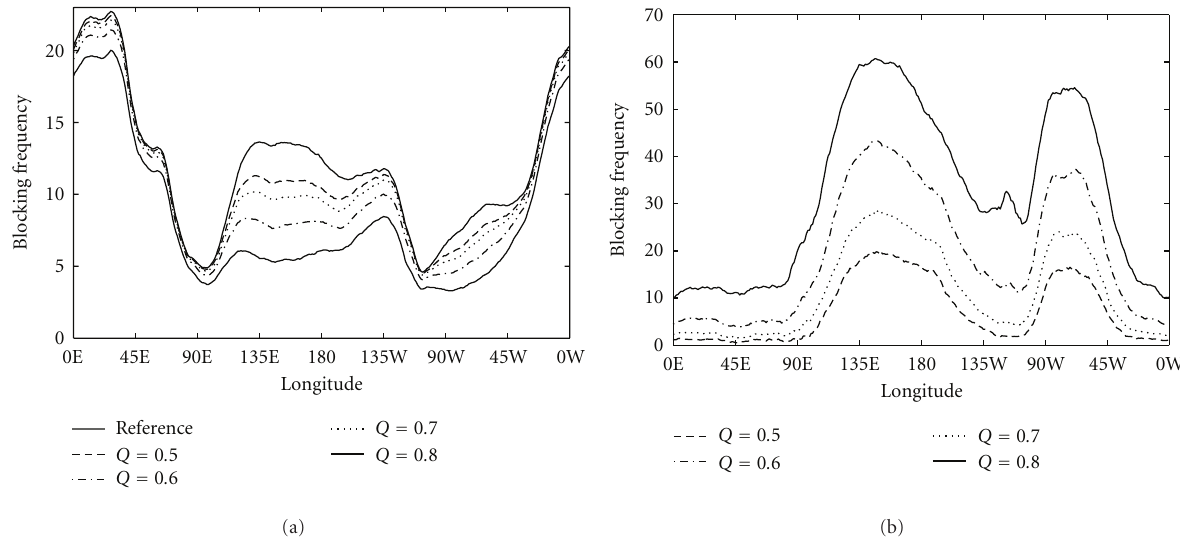
Figure 3: Quantile filter: Northern Hemisphere blocking frequency (a) reference setup and varying filter thresholds Q and (b) relative changes.